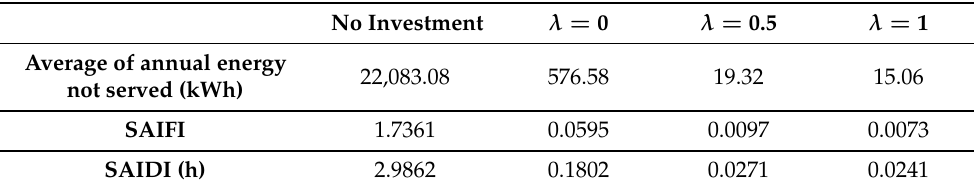
Table 2. Out-of-sample analysis—Reliability metrics: Average annual energy not served, SAIFI, and SAIDI.